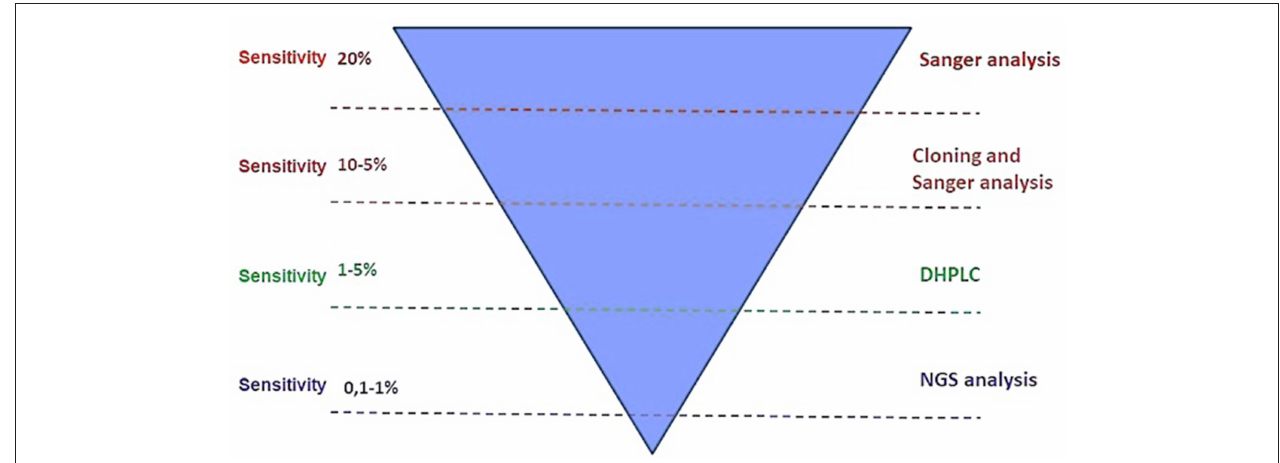
FIGURE 6 | Sensitivity of different molecular biology methods for ABL1 kinase domain mutations detection: the deepest sensitivity is reached by Next Generation Sequencing (NGS) tools.